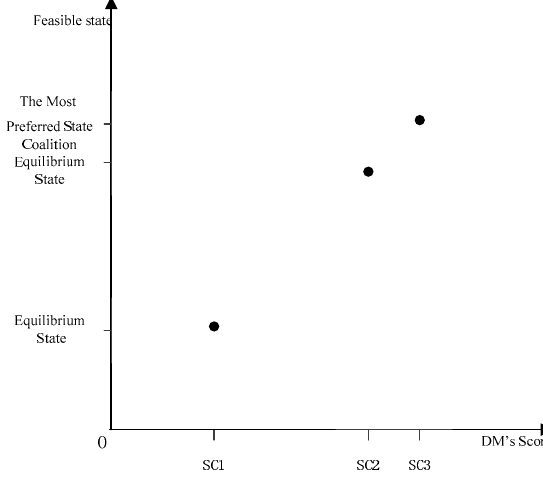
Figure 1. Decision Makers’ (DMs’) Score Coordinate System.